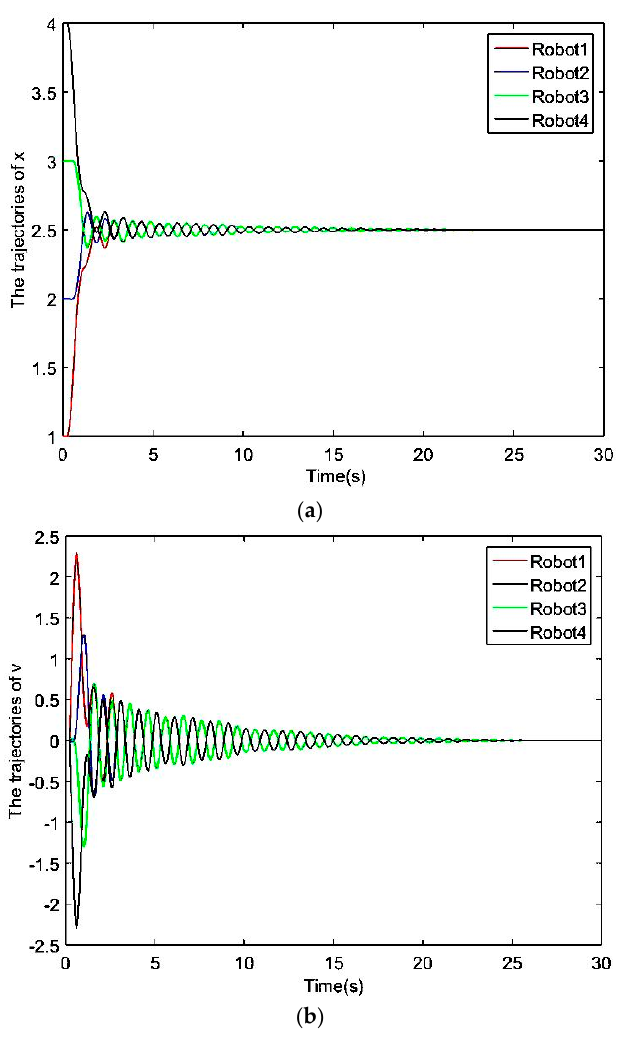
Figure 2. Experiment 1 Group 1 simulation results; x is position, v is velocity. ( a ) Trajectory of x changing with time; ( b ) Trajectory of v changing with time.